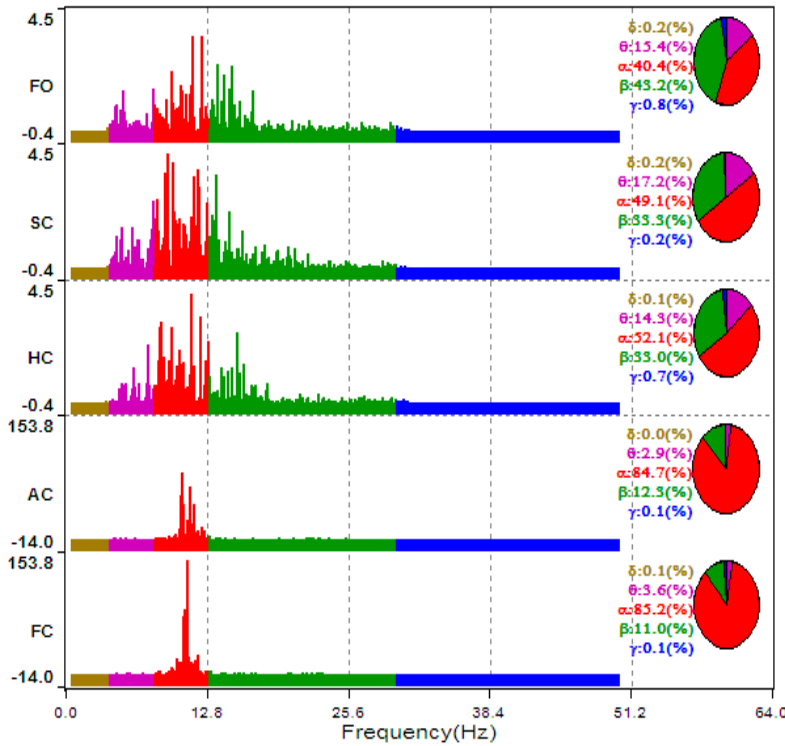
Figure 5. The typical changes of power percentage for one trial EEG signals as the increase of ECD.